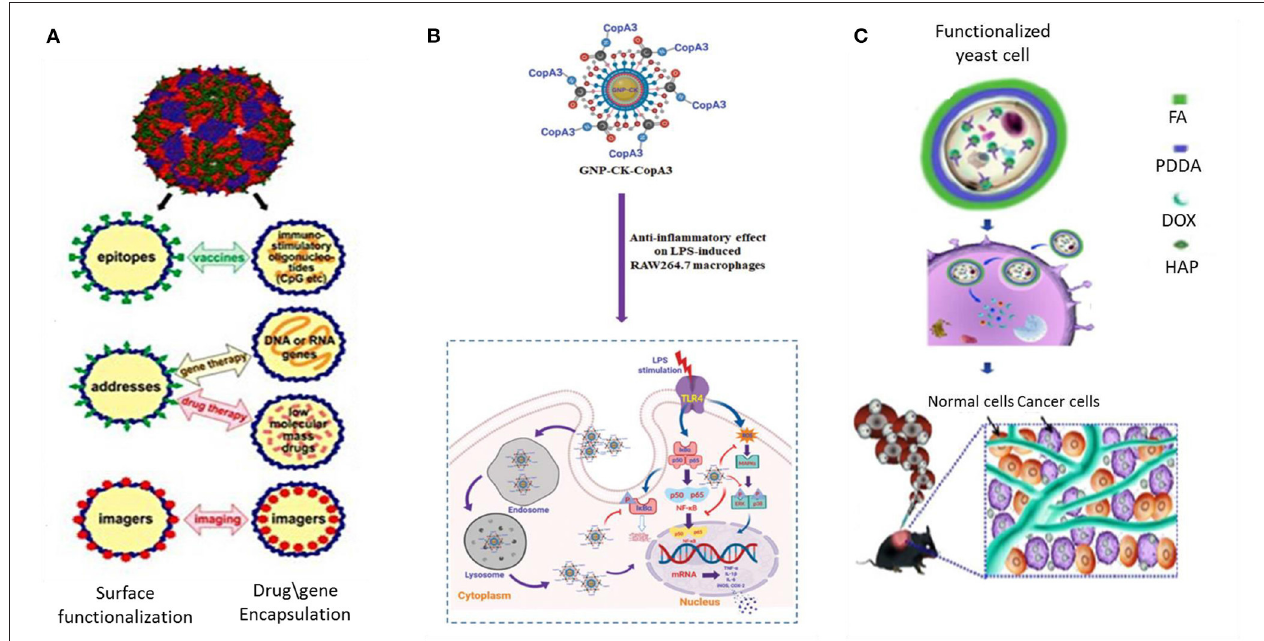
FIGURE 4 | Application of viruses, bacteria, and yeast cells in drug delivery and targeting. (A) RNA phage VLP as scaffold for foreign epitopes or encapsulating immunostimulating adjuvants (CpG) in vaccine delivery, drug or gene delivery and as bioimaging agents for MRI and PET based diagnosis (Pumpens et al., 2016). (B) Active targeting of a biosynthesized peptide CopA3 surface conjugated and ginsenoside compound K (CK) loaded gold nanoparticles (GNP-CK-CopA3). The particles, once internalized in macrophages, efficiently suppressed expression of pro-inflammatory cytokines through inhibition of NF- κ B and MAPK signaling pathways ( Liu et al., 2020). (C) Biosynthesis of HydroxyAPatite (HAP) nanoscaffold inside yeast cell for dual responsive drug delivery against tumor (Ma et al., 2018). VLP Virus Like Particles, FA Folic Acid, PDDA Poly- (Diallyl Dimethyl Ammonium